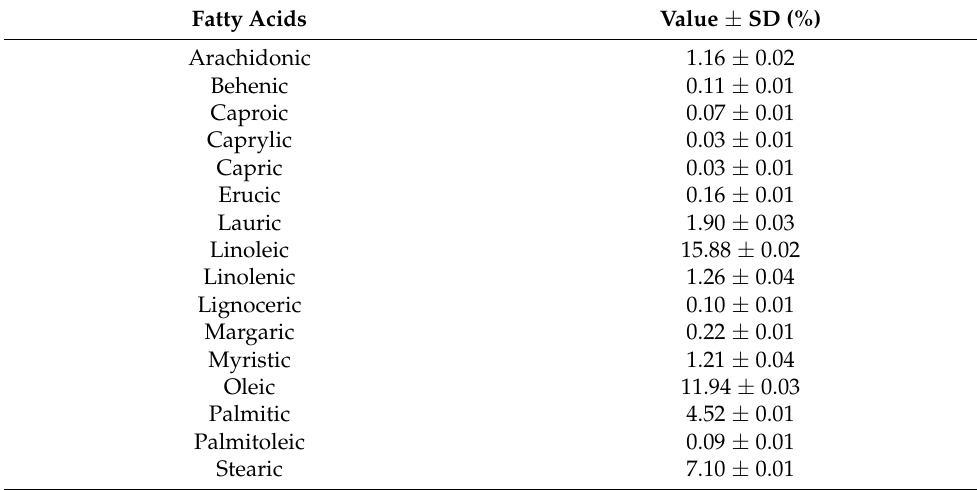
Table 5. Fatty acid composition of baobab fruit pulp.